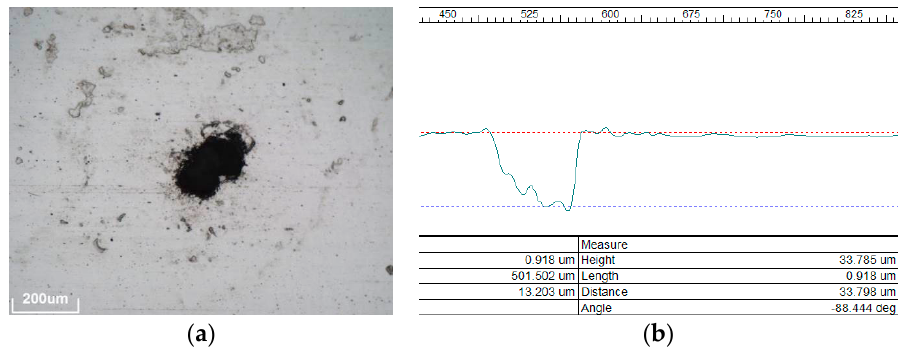
Figure 7. Microscopic image of the degradation due to pitting corrosion in material H ( a ) and depth profile of typical spot ( b ).